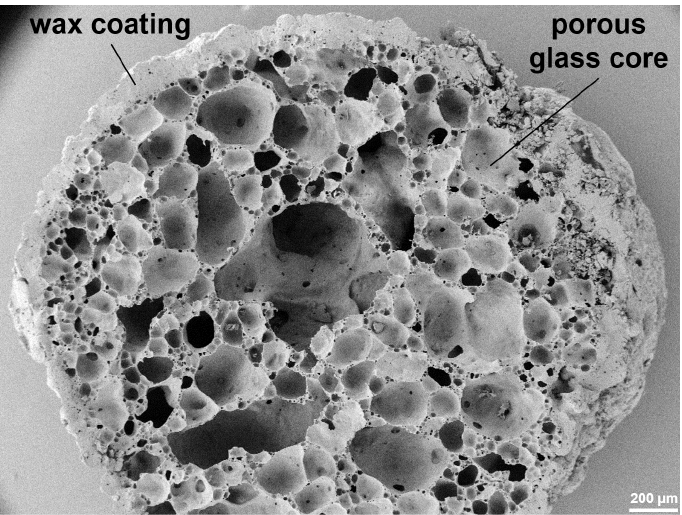
Figure 3. Cross section of Poraver ® particle coated with Candelilla